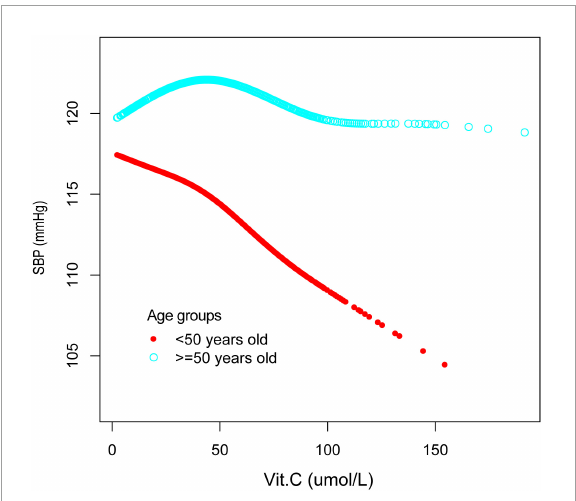
FIGURE5 The relationship between vitamin C and SBP, stratified by age. Sex, race/ethnicity, marital status, education level, ratio of family income to poverty, BMI, smoking states, pulse, ALT, ALP, AST, BUN, globulin, Cr, TG, TC, LDL, HDL, glycohemoglobin, TP, FBG, γ GT, and sUA were adjusted.